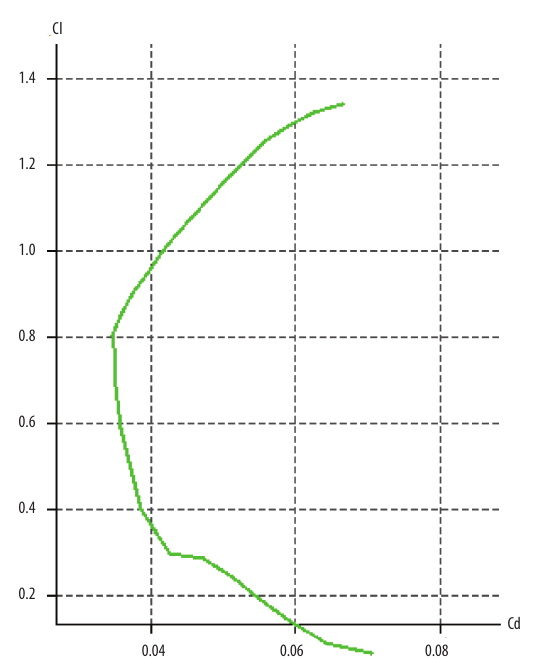
Fig. 3. Dependence of lift coefficient on the coefficient of resistance force